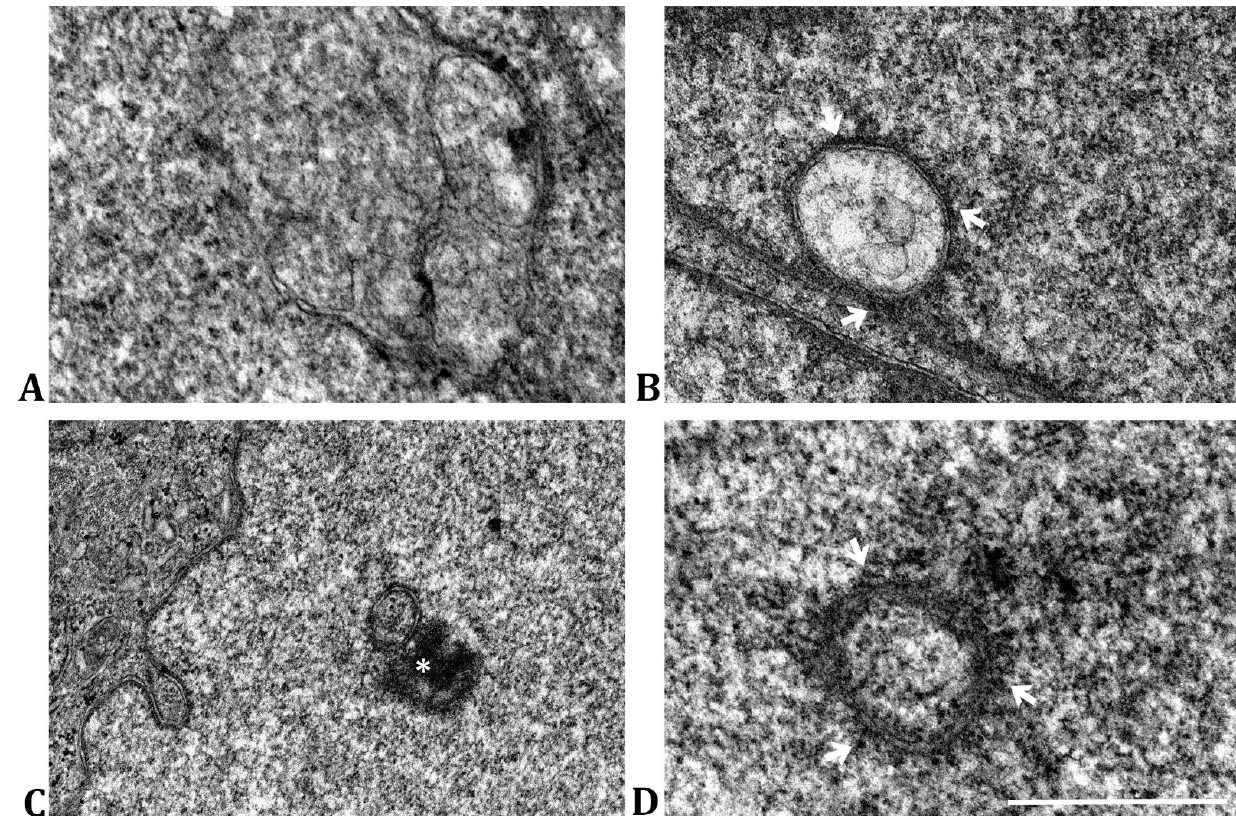
Figure 3. Ultrastructural analysis of membranous inclusions observed in TC7 Cbx3 KO cells. ( A ) Irregular double membrane inclusion, observed next to the nuclear envelope. ( B ) Inclusion of the double spherical membrane, observed next to the nuclear envelope (arrows). The poorly electrodense nature of its contents can be appreciated. Arrows indicate the presence of ribosomes. ( C ) Inclusion of double spherical membrane, observed next to a large patch of heterochromatin (asterisk), suggesting the preference of these structures towards regions of gene repression. ( D ) Detail of small double spherical membrane inclusion, surrounded by ribosomes (arrows). n = 5 clones (generated by 1 sgRNA) per condition. Scale bar: 400 nm.